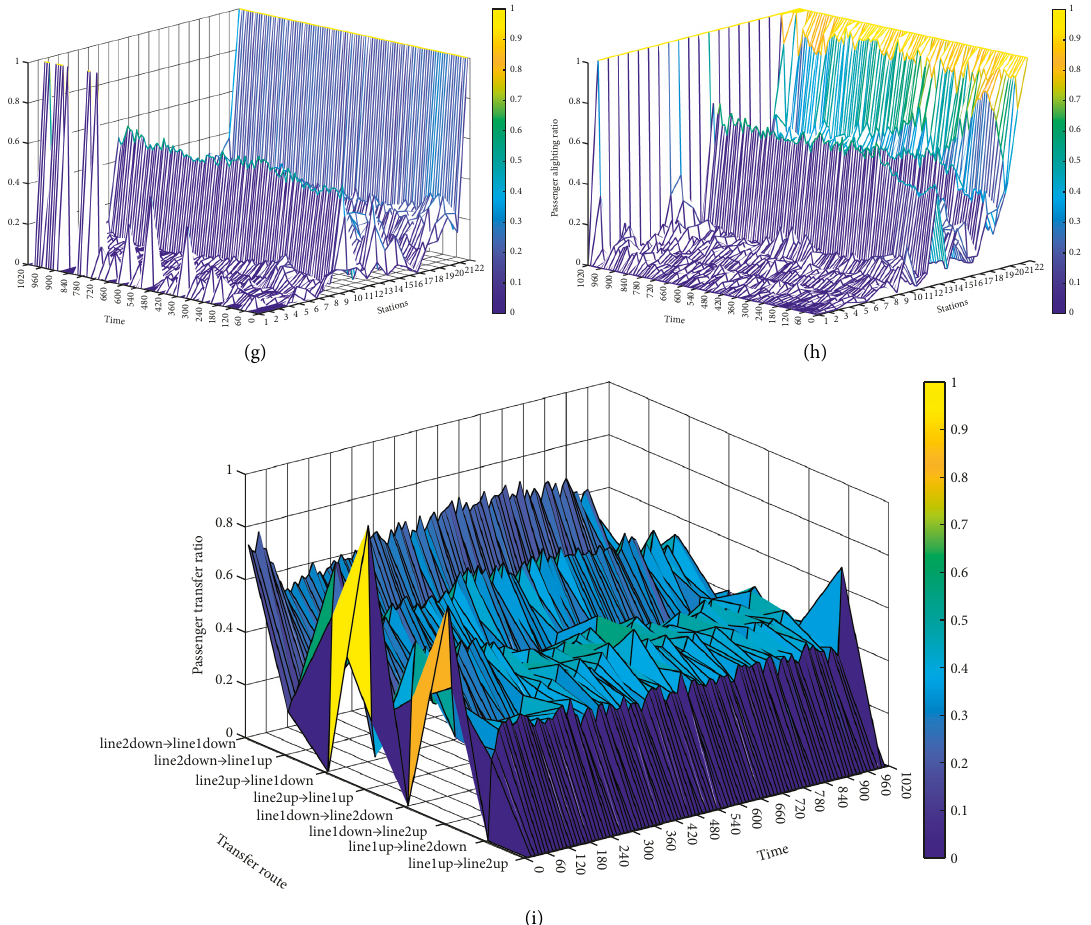
Figure 19: The passenger demand distribution in the real-world case. (a) PAS i ( t ) in Line 1, (b) PAS i ( t ) in Line 2, (c) PAS i ( t ) in Line 3, (d) PAS i ( t ) in Line 4, (e) PRA i ( t ) in Line 1, (f) PRA i ( t ) in Line 2, (g) PRA i ( t ) in Line 3, (h) PRA i ( t ) in Line 4, and (i) PRT i,i ′ ( t )